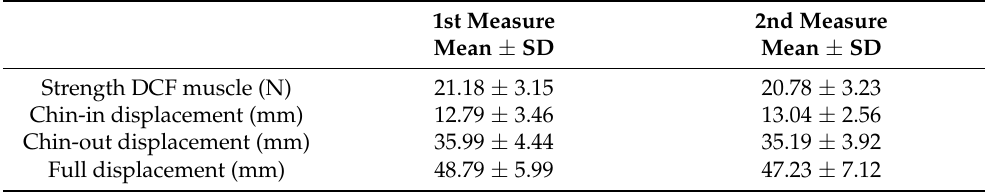
Table 1. Descriptive data of displacement movement and strength of deep cervical flexor muscles.